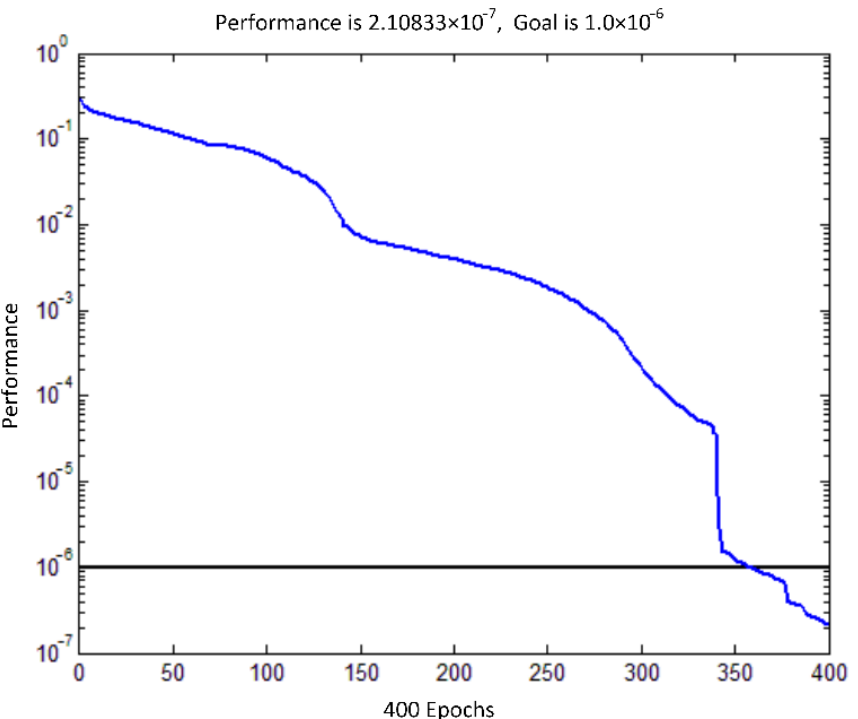
Figure 6. RBFNN training residual curve. For the given four groups of fault cases, the mission decision making and trajectory planning are performed using the trained RBFNN and the ATU-IGM, and the simulation results are obtained as shown in Figures 7–11.